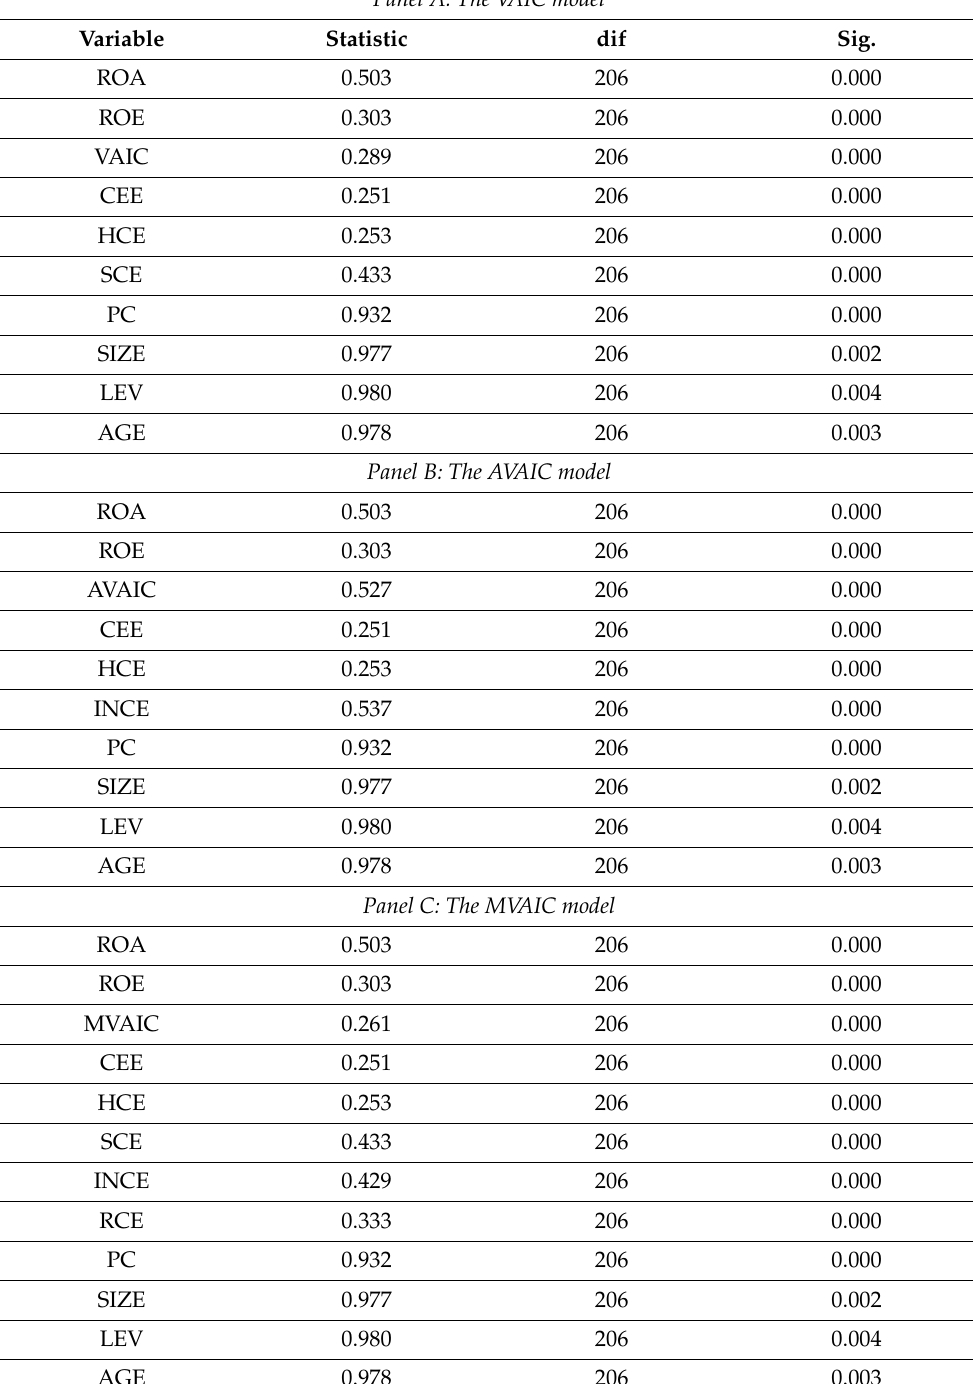
Table 4. Normality